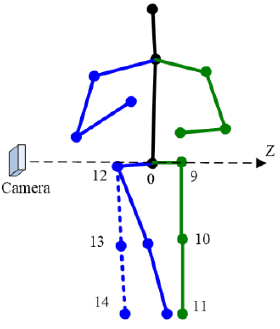
Figure 9. Drifted right leg under side view.